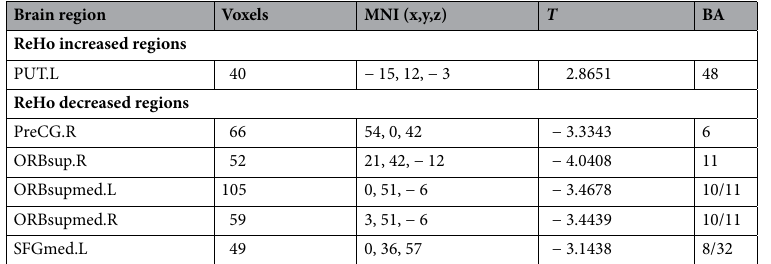
Table 1. Regions of increased/decreased ReHo in children with GHD. ReHo regional homogeneity, GHD growth hormone deficiency, MNI (x,y,z) coordinates of the peak voxel in the MNI space, t the statistical value of peak voxel, with a positive t- value indicating an increased ReHo and a negative t- value indicating a decreased ReHo in patients with GHD, BA Brodmann’s area, L left, R right, PUT putamen, PreCG precentral gyrus, ORBsup superior frontal gyrus, orbital part, ORBsupmed superior frontal gyrus, medial orbital, SFGmed superior frontal gyrus,